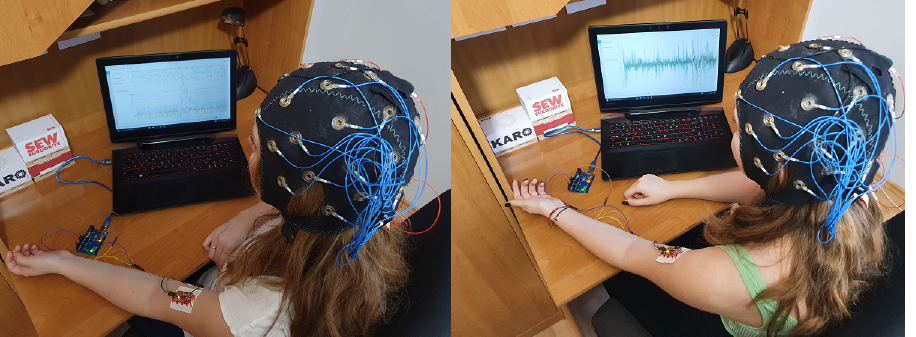
Figure 3. An example of conducting the study on two of the